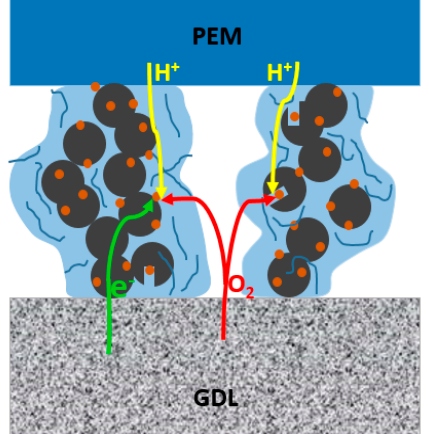
Figure 1. Schematic diagram of the proton exchange membrane fuel cell (PEMFC) catalyst layer between the PEM and GDL.